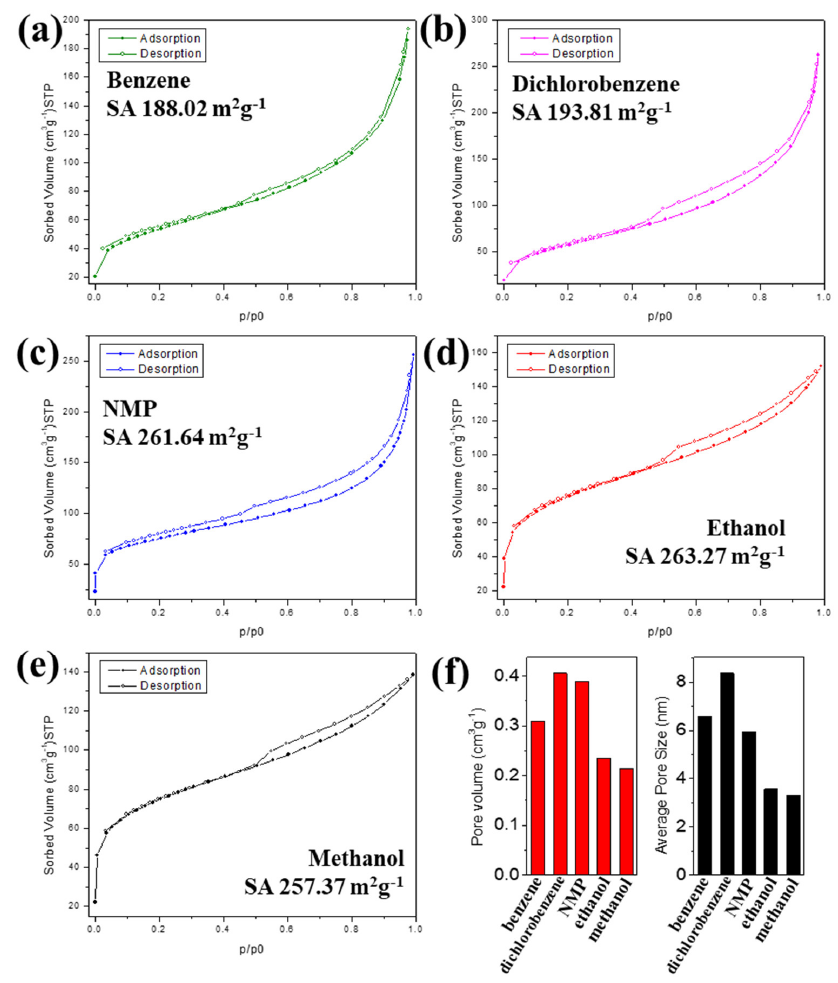
Figure 6. Nitrogen adsorption–desorption isotherms of carbon fibers grown by ( a ) benzene, ( b ) dichlorobenzene, ( c ) NMP, ( d ) ethanol, and ( e ) methanol SPGS at 77 K. ( f ) Pore volume and average pore size.